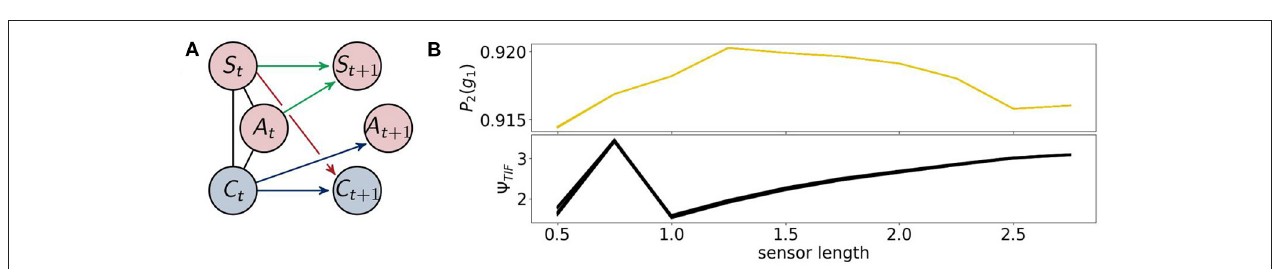
FIGURE 10 | (A) the architecture of the controller driven agents and (B) the probability of survival (top) and the total information flow 9 TIF (bottom).